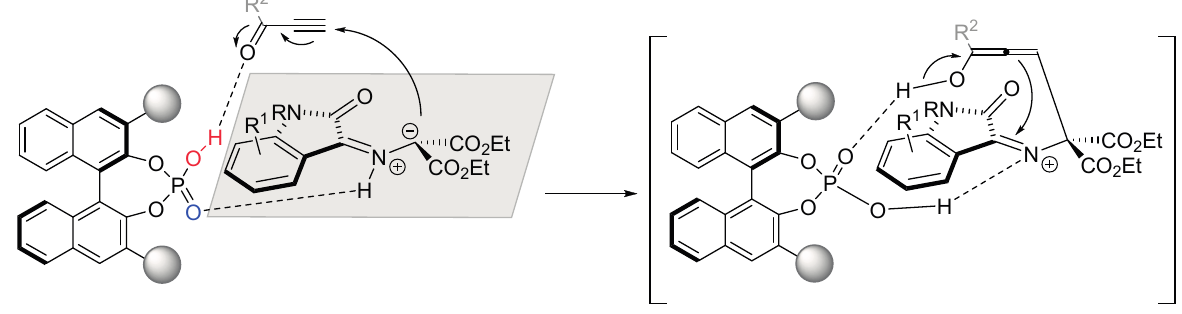
Figure 8. Proposed mechanism of 1,3-dipolar cycloaddition of alkynes with isatin-derived azomethine